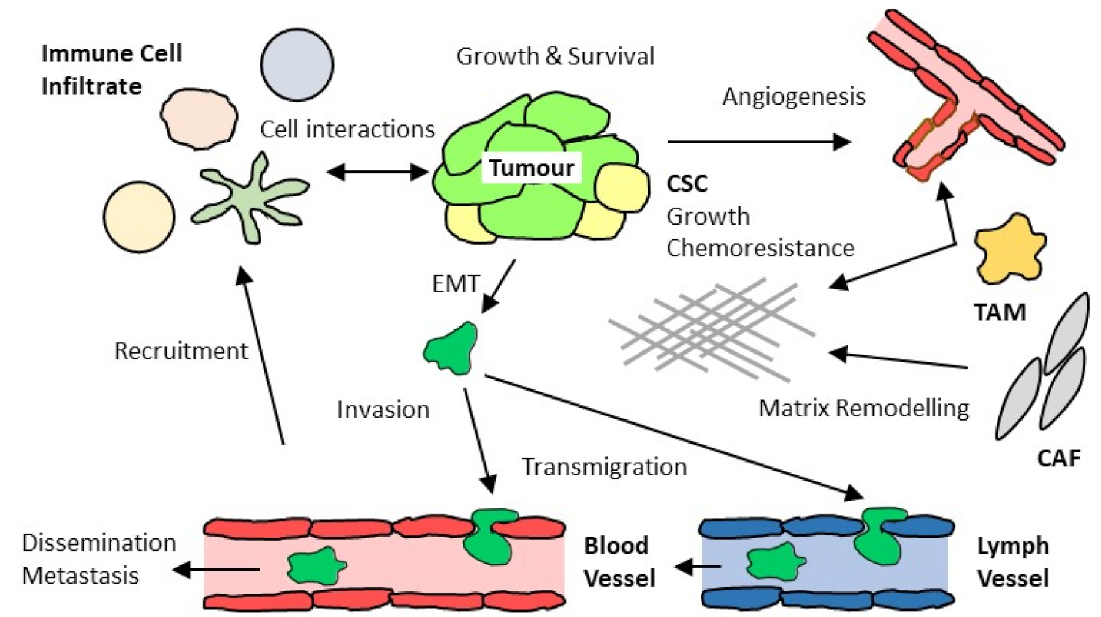
Figure 1. Complex roles of chemokines encompassing both tumor inhibiting and promoting functions. Chemokines are produced directly by tumor cells, tumor -associated vasculature, tissue macrophages and fibroblasts as well as recruited immune cells. Local chemokines shape tumor progression in many ways, often in synergy with other cytokines and metabolites. These include: recruitment of circulating immune cells and/or their retention in the tumor microenvironment; immune cells exerting pro- or anti-tumor immune responses; growth of tumors, including growth and chemoresistance of cancer stem cells; induction of epithelial–mesenchymal transition in tumor cells followed by their transmigration into lymphatic and/or blood vessels; dissemination of tumor cells to sites of secondary tumor growth; induction of angiogenesis; remodeling extracellular matrix by tumor-associated macrophages and cancer-associated fibroblasts. EMT, epithelial–mesenchymal transition; CSC, cancer stem cell; TAM, tumor-associated macrophage; CAF, cancer-associated